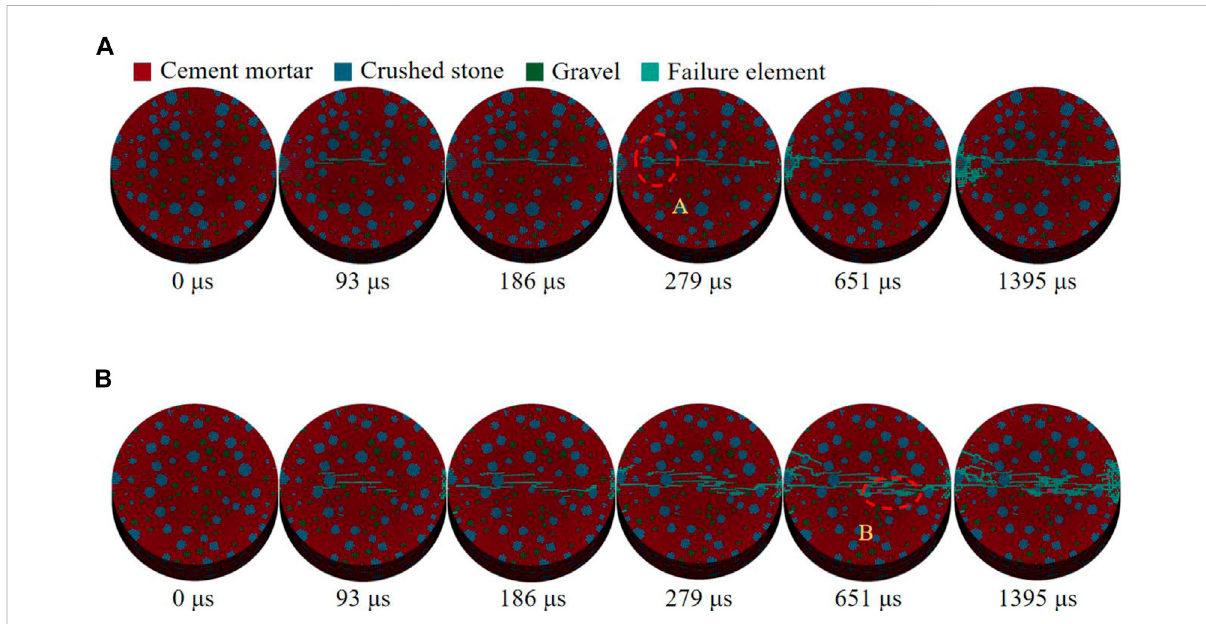
FIGURE 8 Simulation failure process of the grouting specimens. (A) _ ε = 24.8 s − 1 , (B) _ ε = 45.1 s − 1